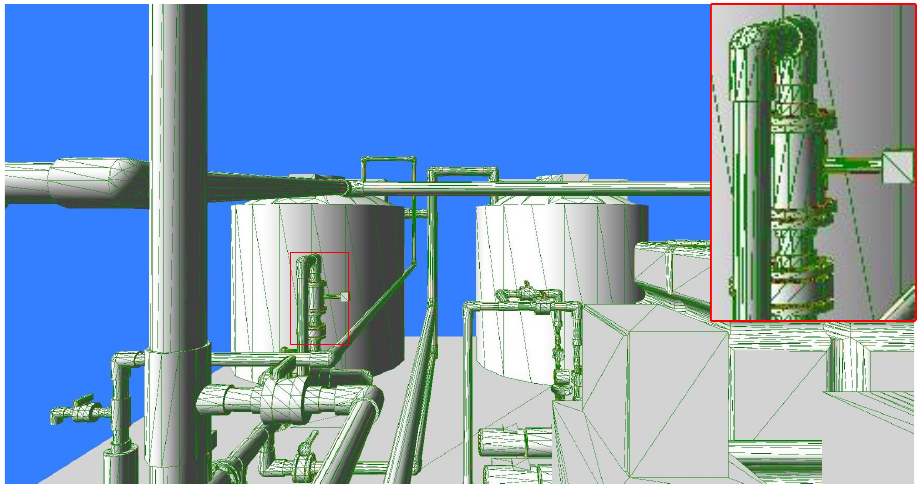
Figure 8. Color-coded edge complex pixels based on unique fragment counts. Green means two fragments, blue means three, and red means four.